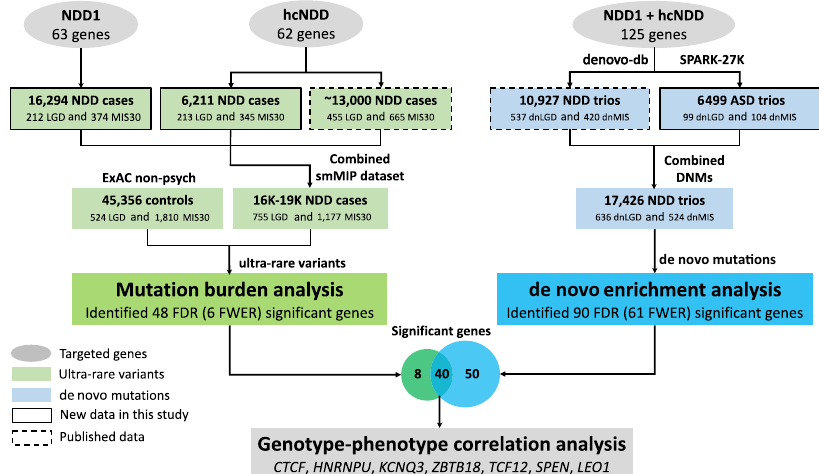
Fig. 1 Overview of study design. Targeted sequencing was performed in probands for two gene panels: NDD1 (63 genes) and hcNDD (62 genes). Gene and variant counts are after QC. The same categories of variants were retrieved from three previously published smMIP studies for 62 hcNDD genes. All smMIP variants were combined; redundant samples were eliminated and compared to the same category of variants from ExAC non-psych controls. The number of variants is after the exclusion of false positive variants and variants with insuf fi cient coverage in ExAC. Mutation burden analysis identi fi ed 48 FDR signi fi cant genes ( q mutBurden < 0.05, Benjamini – Hochberg correction for 125 genes), of which six reached FWER signi fi cance ( p mutBurden < 1.25E − 06, Bonferroni correction for 20,000 genes and two tests); DNMs of the 125 genes used in this study were identi fi ed from exome sequencing in 10,927 published NDD trios and 6,499 new ASD trios that combined as 17,426 NDD parent – child trios. A separate de novo enrichment analysis, using two statistical methods (CH model and denovolyzeR), identi fi ed 90 FDR signi fi cant genes ( q dnEnrich < 0.05, Benjamini – Hochberg correction for 18,946 genes in CH model and 19,618 genes in denovolyzeR), of which, 61 genes reach FWER signi fi cance ( p dnEnrich < 3.64E − 07, Bonferroni correction for 19,618 genes and seven tests) for excess DNM. There is a signi fi cant overlap (40 genes) of the signi fi cant genes suggested by the two approaches. Then we performed genotype – phenotype correlation analysis for seven NDD risk genes ( CTCF , HNRNPU , KCNQ3 , ZBTB18 , TCF12 , SPEN , and LEO1 ) and present a clearer clinical picture of each